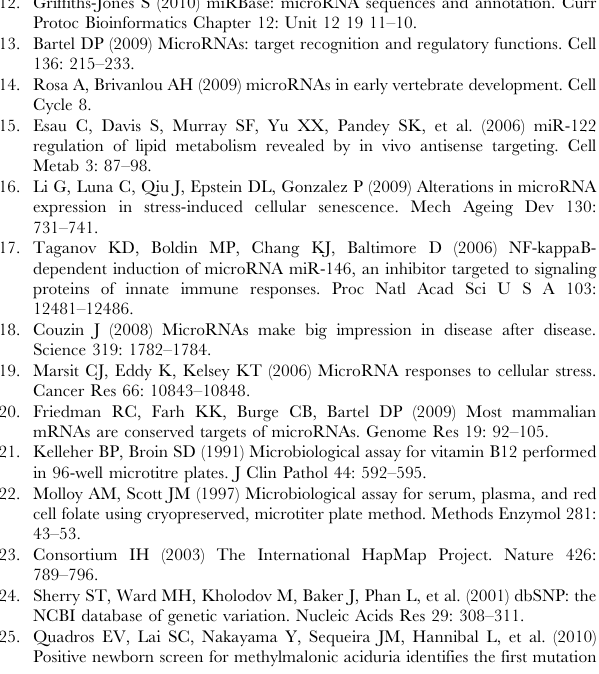
Table S2 Complete metabolite association results for single nucleotide polymorphisms (SNPs) within predict- ed human microRNA target sites in OCM genes. * indicates a significant (p , 0.05) SNP-metabolite association;